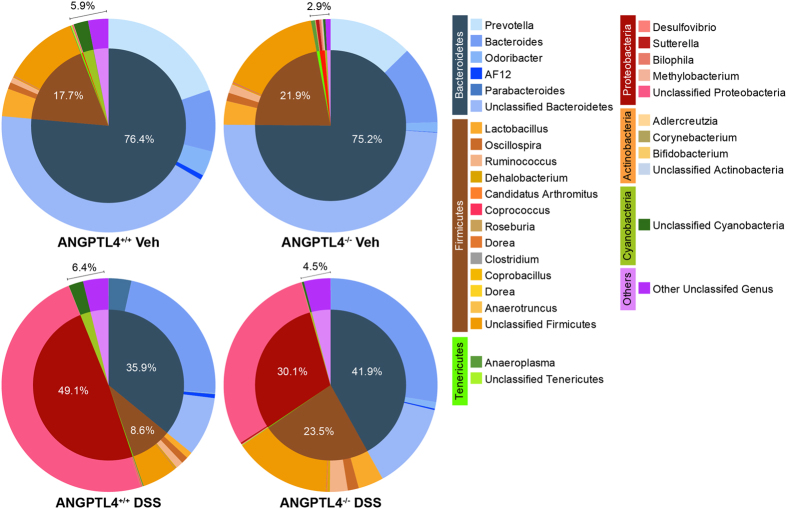
ANGPTL4 deficiency does not influence commensal microbe composition.Pie charts showing the commensal microbe landscape at steady state (upper panel) and after DSS treatment (lower panel) of age- and gender- matched ANGPTL4+/+ and ANGPTL4−/− littermates. Values in the charts denote mean percentage of abundance. n = 6 mice per group.